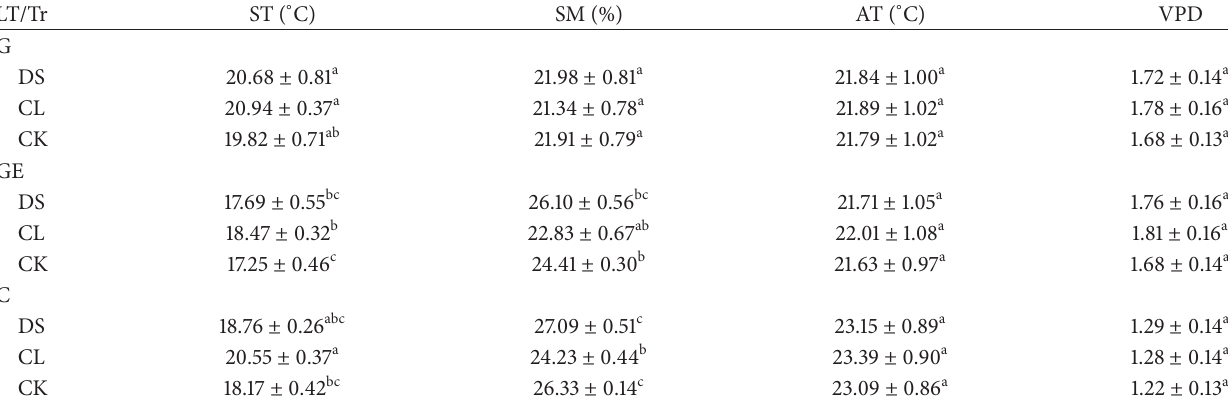
Table 1: Microclimate characteristics of land use types (LT) and vegetation cover treatments